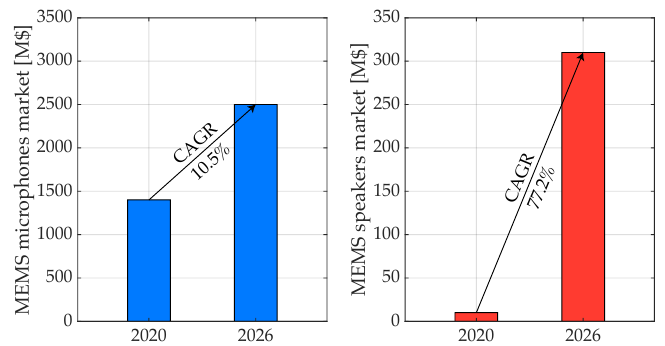
Figure 1. MEMS microphones and speakers market